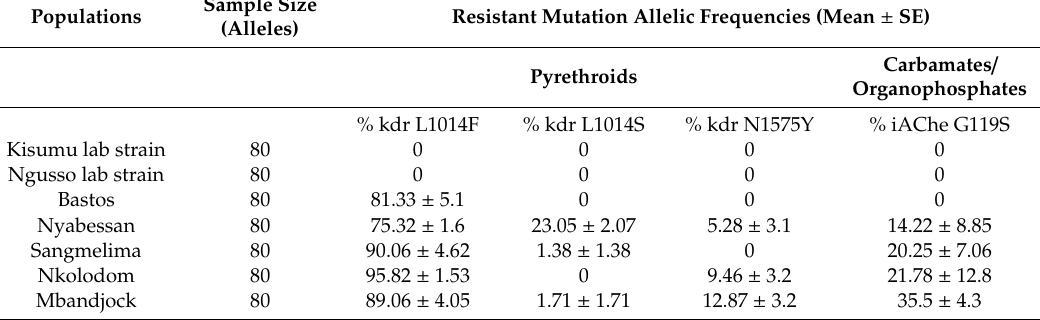
Table 3. Incidence of resistance alleles in di ff erent populations of An. Gambiae s.l. mosquitoes.